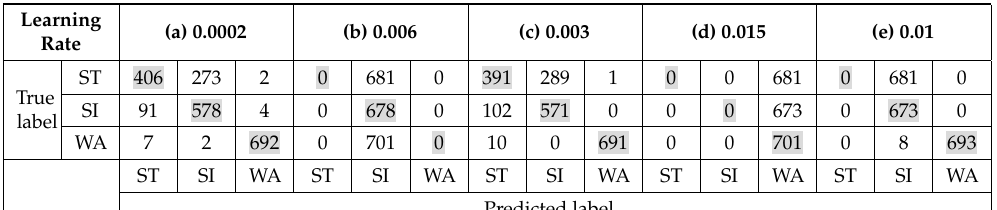
Table 8. Confusion matrices: (OR + LA1 + SH + LA2)—100-feature vector